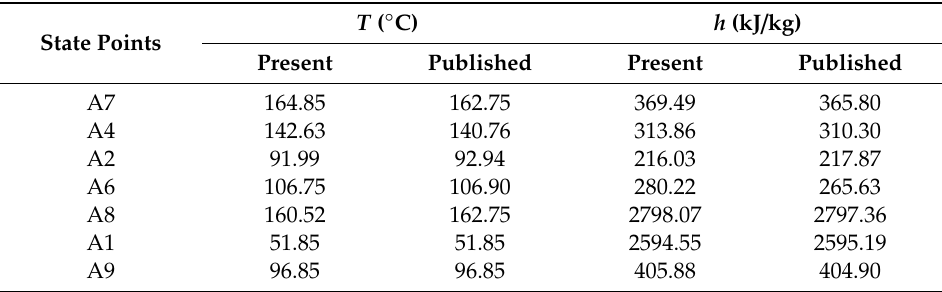
Table 7. Comparison between the simulated results and the published data for LiBr-H 2 O AHP. T ( ◦ C) h (kJ / kg) State Points Present Published Present